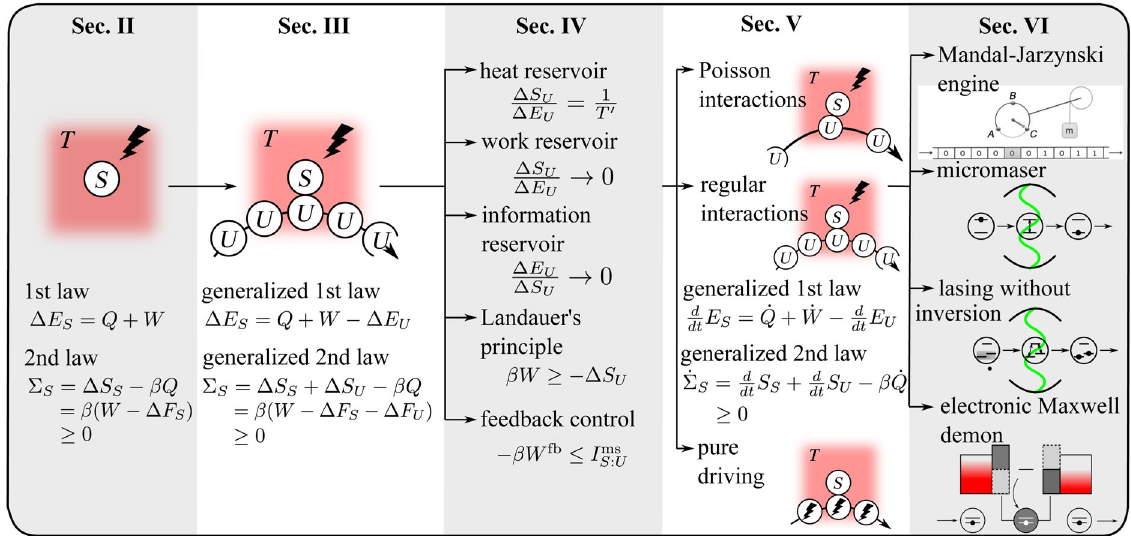
FIG. 1. Overview of the structure of the article covering its main results and applications. Here and in the following, E F denote the energy, entropy, and nonequilibrium free energy of the system ( S ) or unit ( U ). Q is the heat flowing from the reservoir at S;U ≡ 1 ), and W is the work done on the system. Furthermore, Σ inverse temperature β ¼ T − 1 ( k B the mutual information between the system and unit. The picture of the Mandal-Jarzynski engine was taken from Ref.